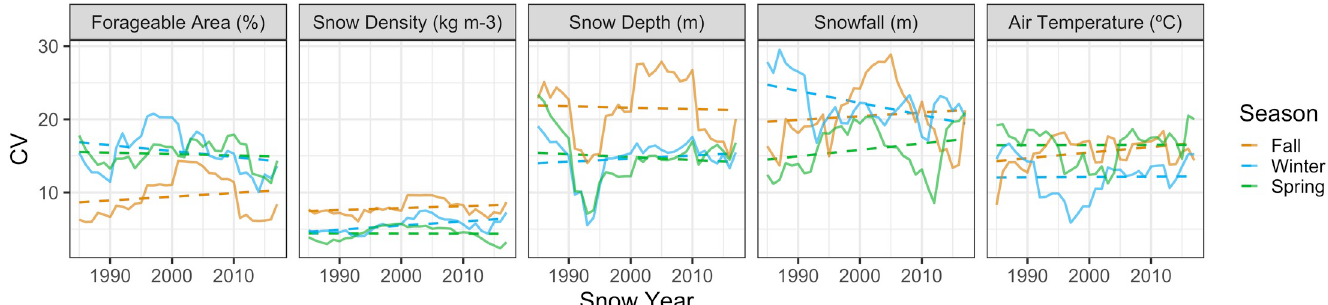
Fig 5. Time series of 10-year rolling coefficient of variability (CV) for each snow and climate covariate by season within the Jacksina sheep survey unit within Wrangell-St. Elias National Park and Preserve,